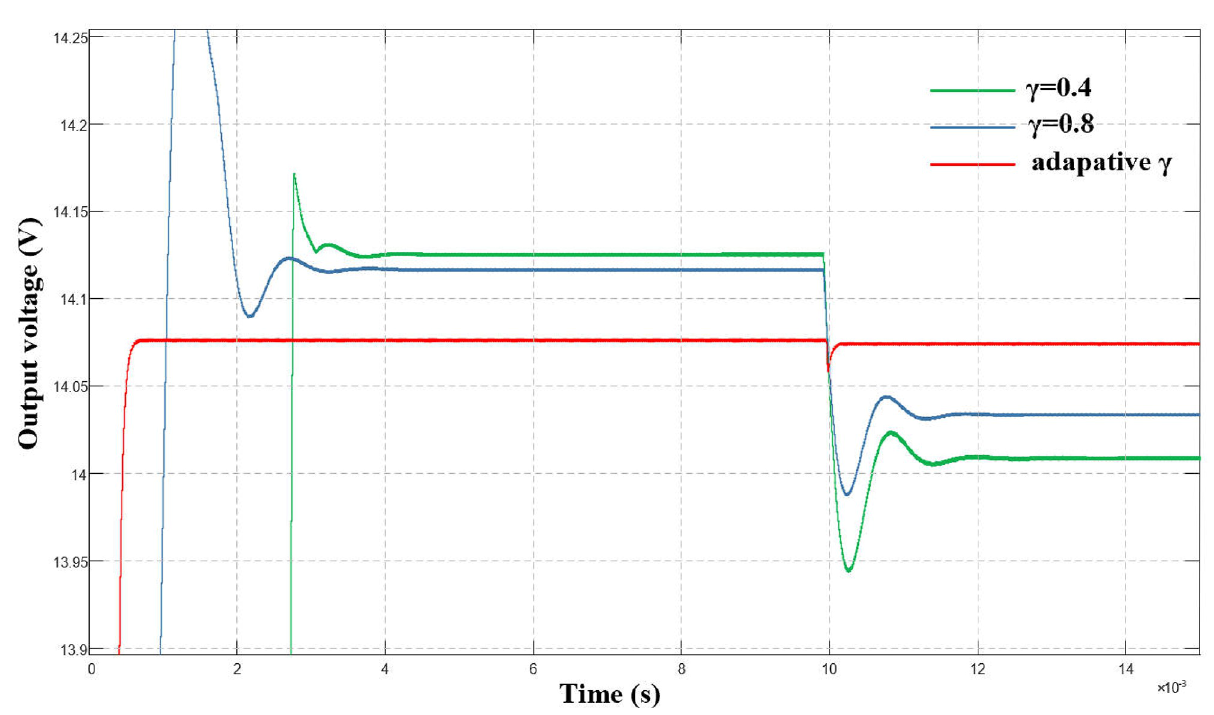
PLOS ONE | https://doi.org/10.1371/journal.pone.0275056 September 22,